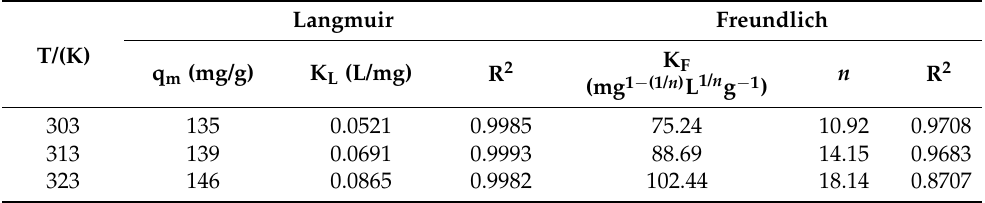
Table 3. Parameters of Langmuir and Freundlich isotherms for the adsorption of Cu 2+ .